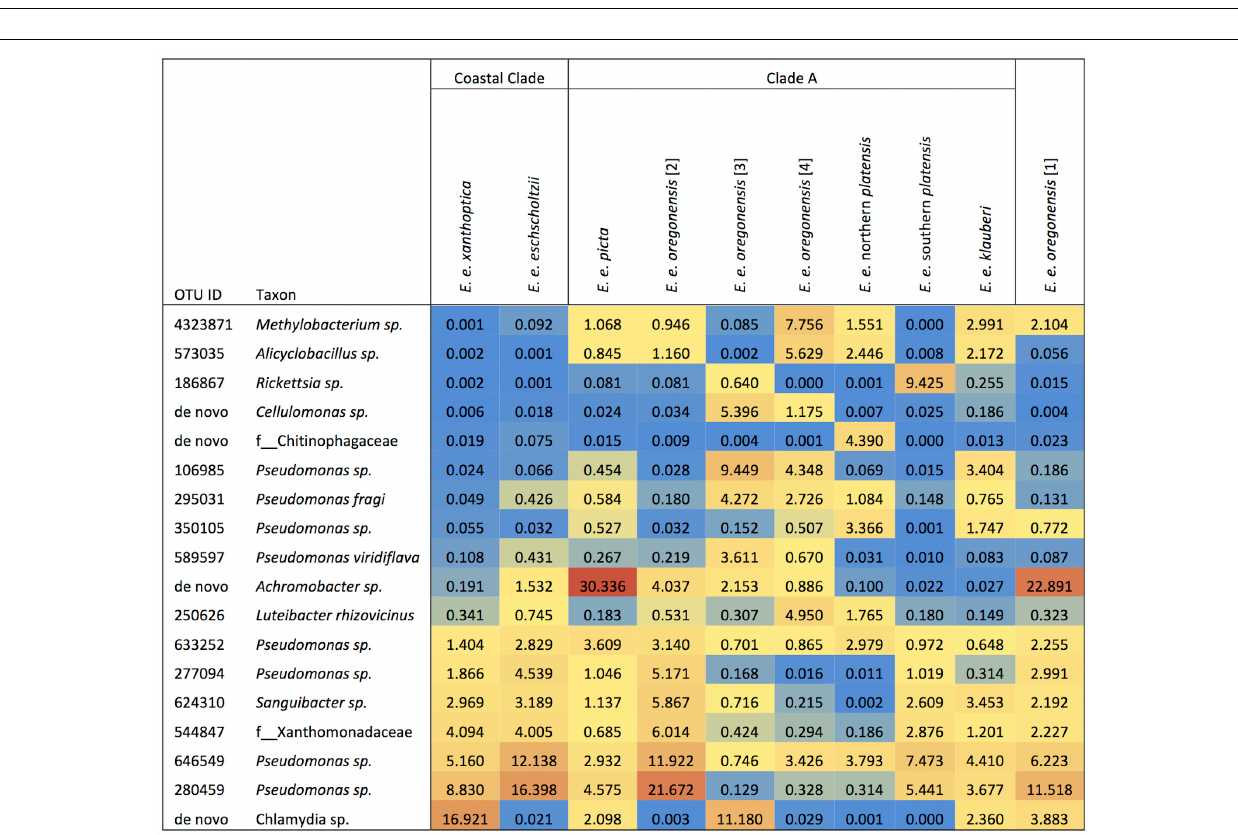
FIGURE 3 | Principle coordinates analysis plots of unweighted and weighted UniFrac distances of all salamander and soil samples.